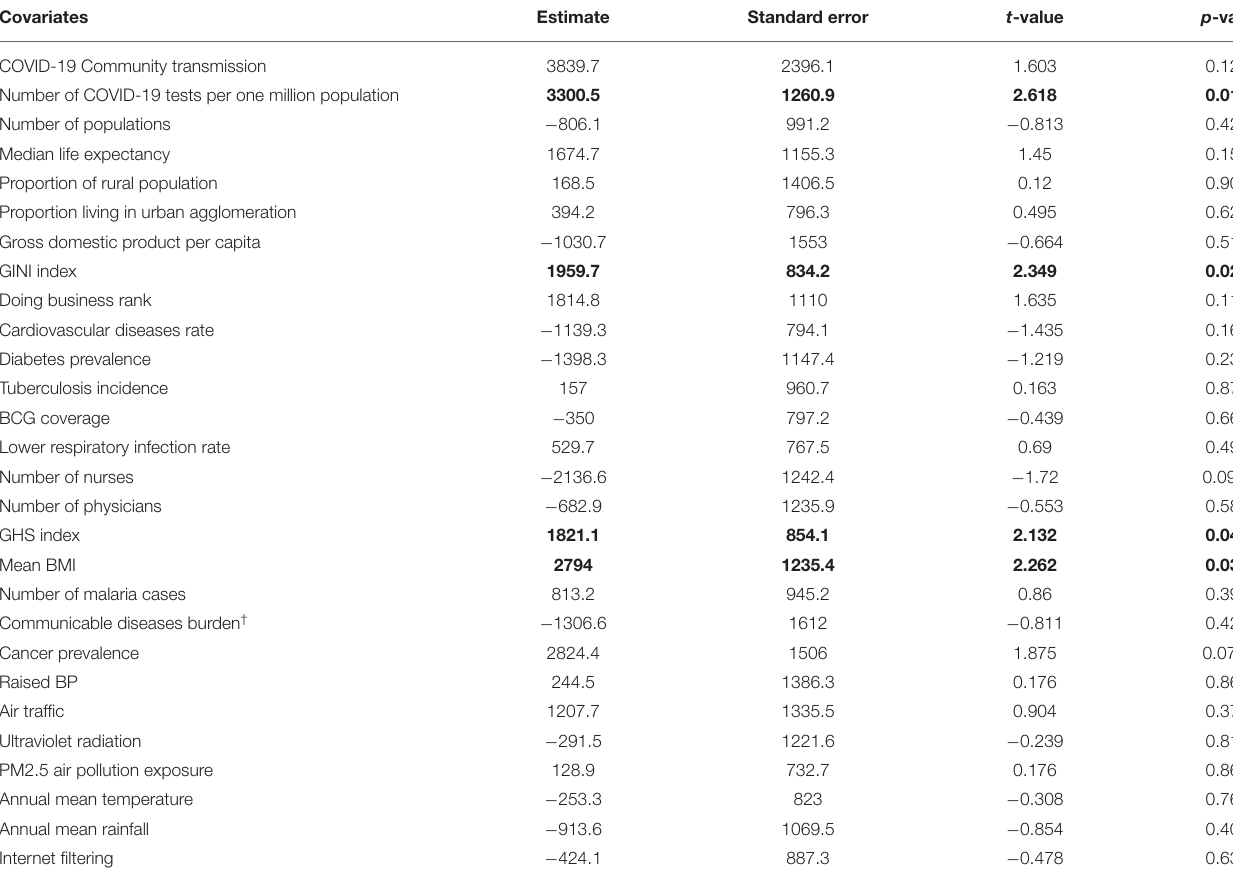
TABLE 2 | Multiple regression analysis using COVID-19 cases per one million populations as the dependent variable.